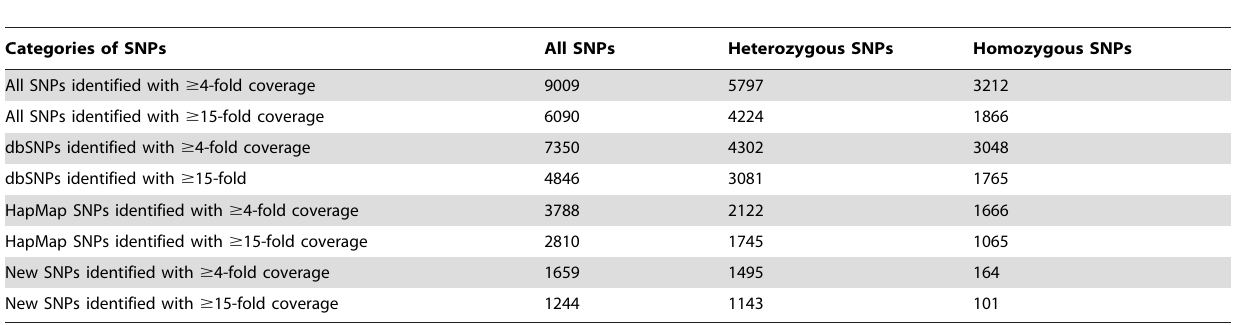
Table 2. Numbers of homozygous and heterozygous SNPs identified in NA12782 at different sequence coverage thresholds.